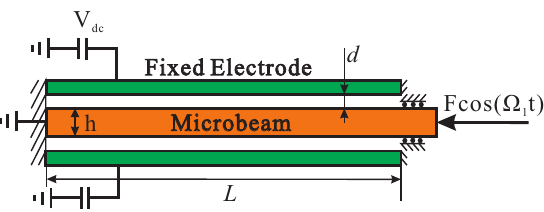
Figure 1. Schematic of an electrically actuated